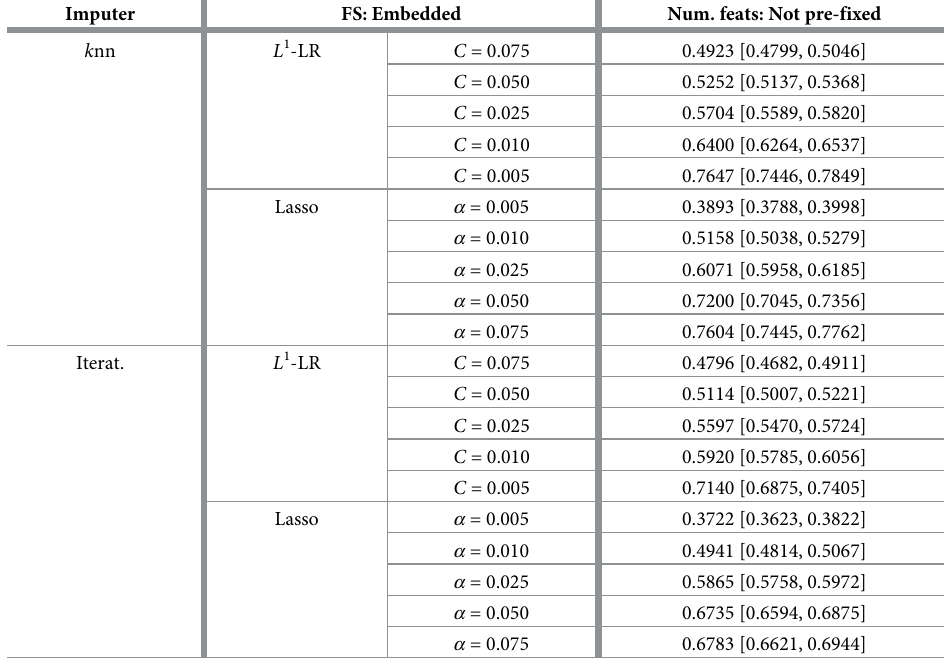
Table 4. Stability for the embedded algorithms. Mean and 95%